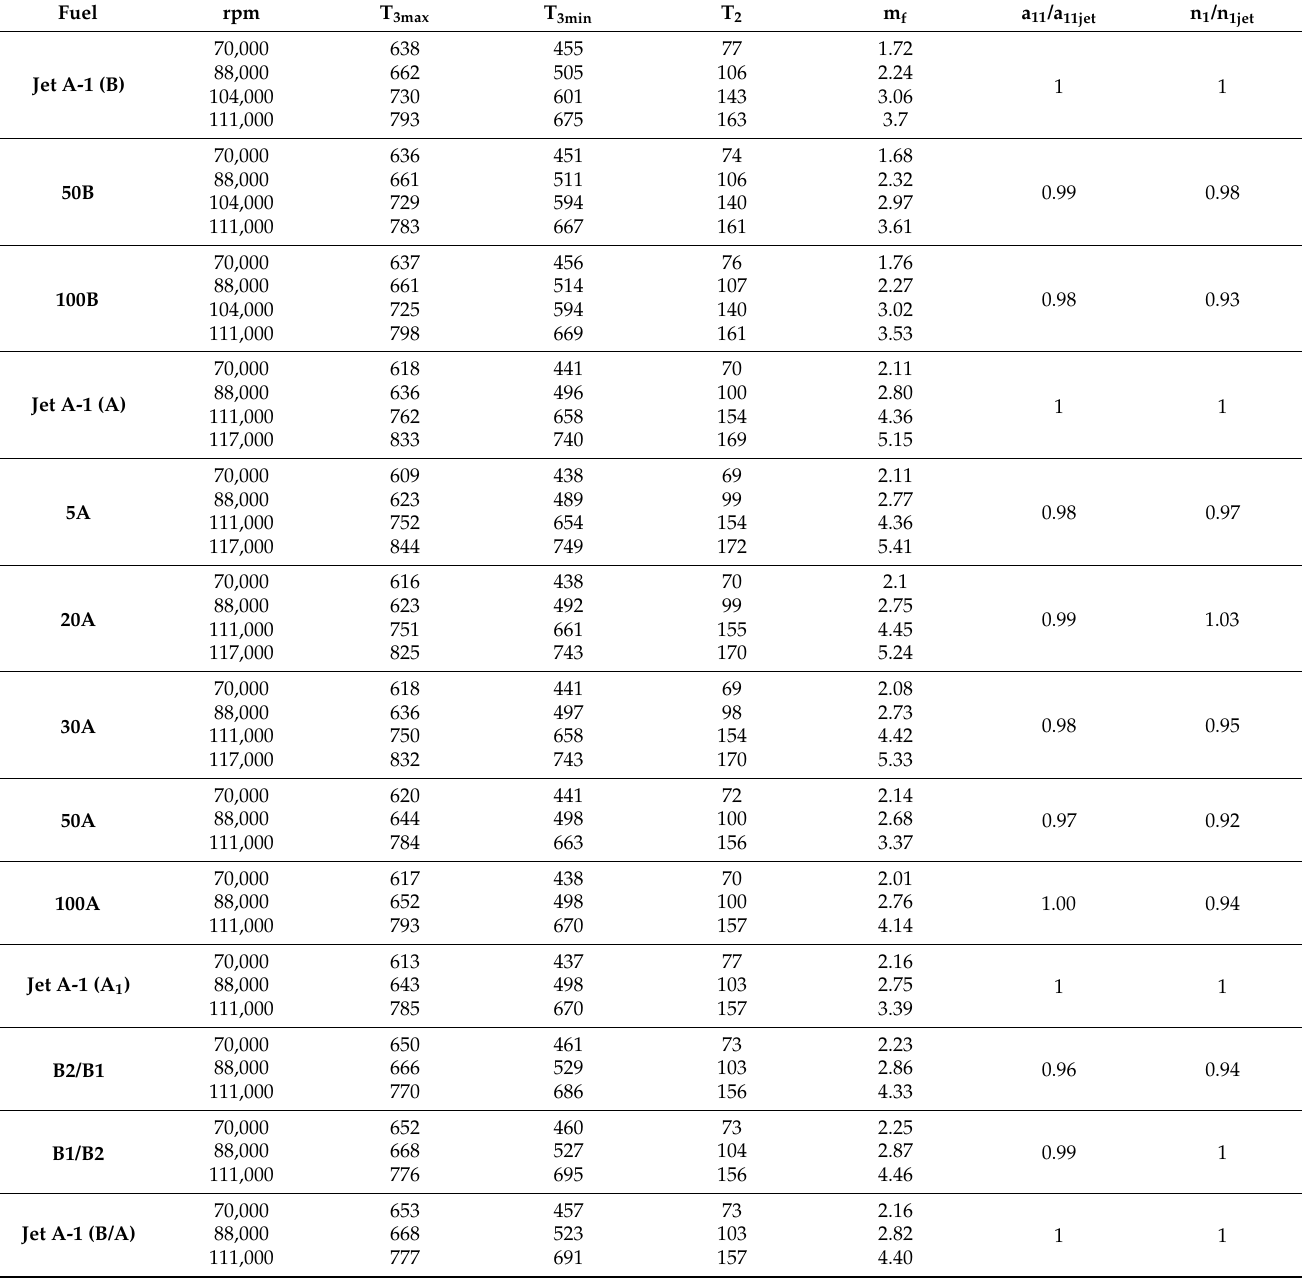
mixtures. Figure 9b indicates that the parameters of power functions depend on the concentration of synthetic components, which in this case is B. Similar dependences were obtained for all tested fuels—mixtures containing synthetic components A and B. The parameters of power functions, experimentally found for all tested mixtures, were related to such parameters obtained for mineral Jet A-1 fuels. This made it possible to compare the course of power functions obtained for mixtures containing synthetic components with the power function obtained for mineral Jet A-1 fuel. Ratios a 11 /a 11jet and n 1 /n 1jet were determined (see Table 4) as the combustion process’ similarity criteria. Table 4. Parameters of empirical dependence (T 3max − T 2 ) / (T 3min − T 2 ) = a 11 m fn1 ; the “jet” index refers to a 11 and n 1 value obtained for the Jet A-1 fuel appropriate for a given sample batch, marked in the table with